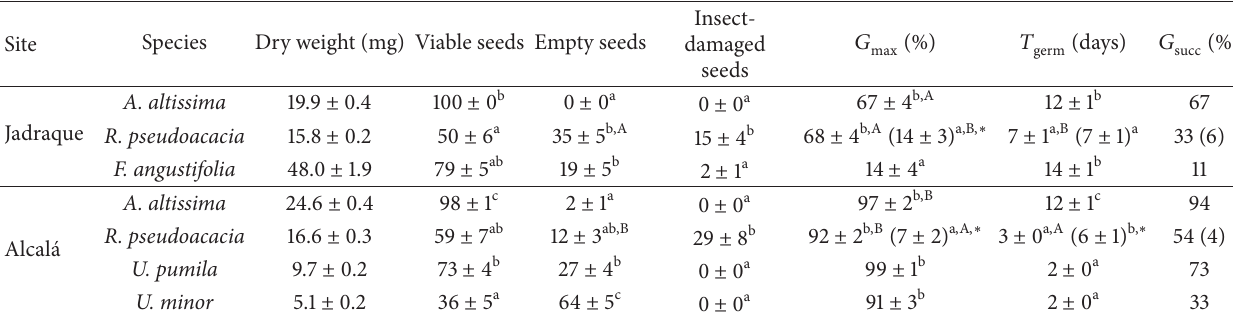
Table 2: Seed mean dry weight, cumulative seed germination ( 𝐺 ∗ % viable seeds) of the studied species in the 2013 experiment (means ± SE). In R. pseudoacacia , values in parentheses correspond to 𝐺 max untreated seeds. In the case of A. altissima and R. pseudoacacia values for different populations (Jadraque and Alcal´a) are